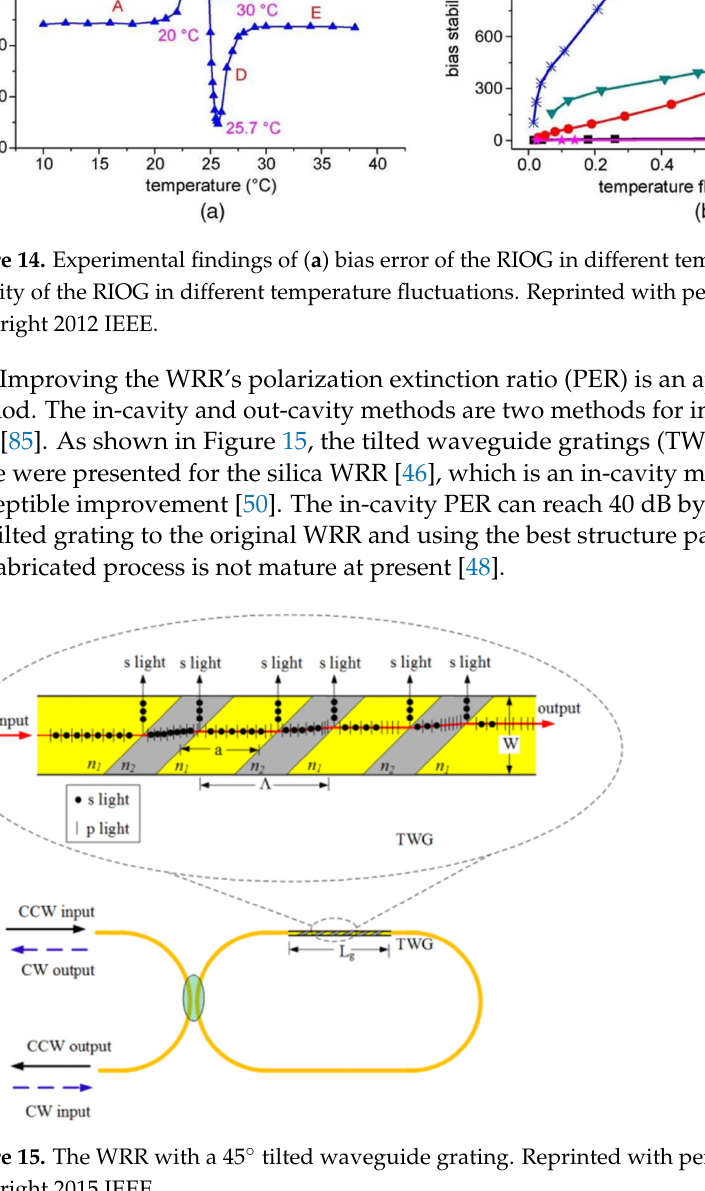
Figure 16. Schematic diagram of the WRR with a single-polarization fiber. These temperature fluctuations in silicon nanophotonics have a bandwidth of several kilohertz, are much less pronounced above a megahertz, and thus can be treated as constant over timescales of microseconds. Khia et al. developed an approach called reciprocal sensitivity enhancement [86], as shown in Figure 17. In a passive network made of isotropic elements (lossy or lossless), switching the input and output ports does not change the observed response from input to output. This approach reduces fluctuation noise because of the temporal separation between the CW and CCW propagating beams in each path and the cancellation of thermal fluctuations using high-frequency optical switching. Critically, this method is more tolerant to the propagation loss of the medium. Using a Mach–Zehnder interferometer (MZI), the ring resonators can be fed from two different directions, and the output toggles between two photodiodes. By adding the two outputs together, information ‘moves’ to the switching frequency and becomes unaffected by thermal drift. The all-integrated optical gyroscope occupies only 2 mm 2 and detects the smallest recorded phase shift (3 nrad).